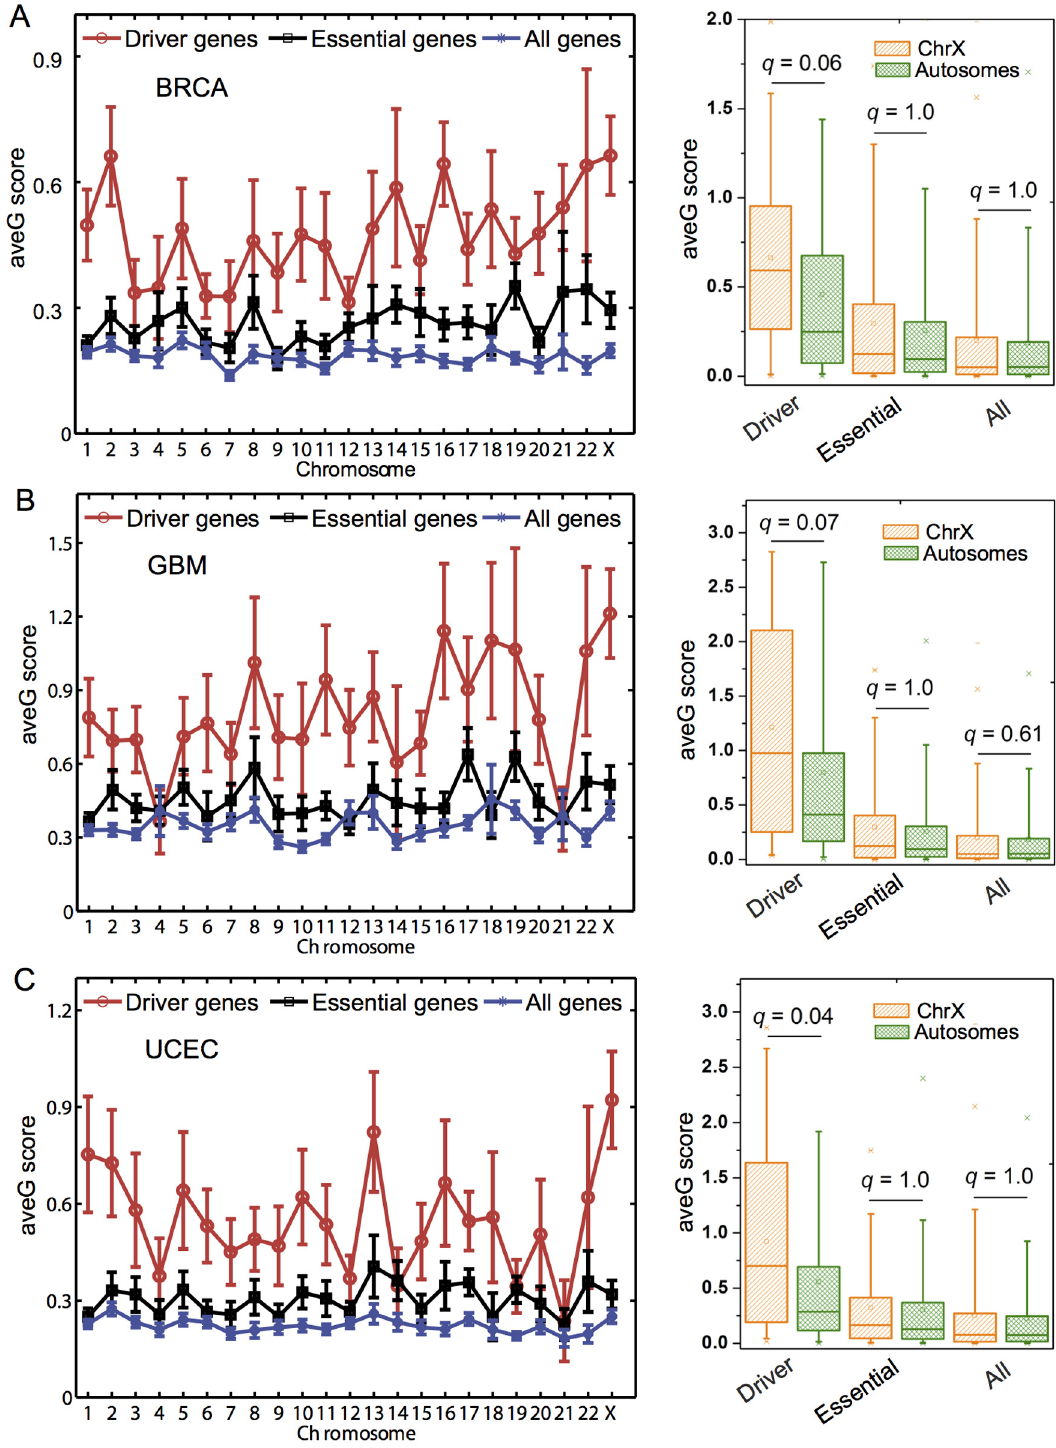
Fig 5. Distribution of average gravitation (ave G ) score for cancer driver genes (Driver), essential genes (Essential), and all genes (All) across 23 human chromosomes in 3 cancer types. The left plots show the distribution of ave G scores for three different genes across 23 human chromosomes in ( A ) BRCA: breast invasive carcinoma, ( B ) GBM: glioblastoma multiforme, and ( C ) UCEC: uterine corpus endometrial carcinoma. The right box plots show the comparison of ave G scores between the X chromosome (ChrX) and all the 22 autosomes (Autosomes) for three different gene sets in the corresponding left three cancer types. The p-values are calculated by the Wilcoxon rank-sum test and corrected by Benjamini-Hochberg multiple testing. The remaining 6 cancer types are provided in S17 Fig. doi:10.1371/journal.pcbi.1004497.g005 PLOS Computational Biology | DOI:10.1371/journal.pcbi.1004497 September 9,